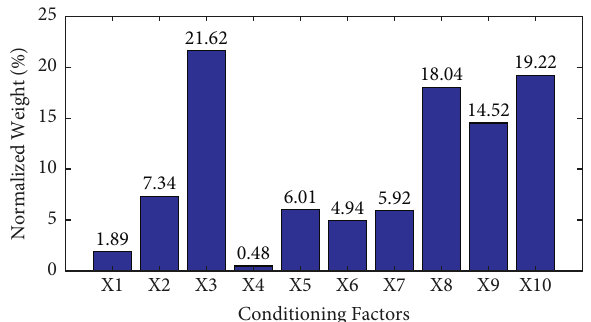
Figure 7: Feature importance computed by ReliefF.